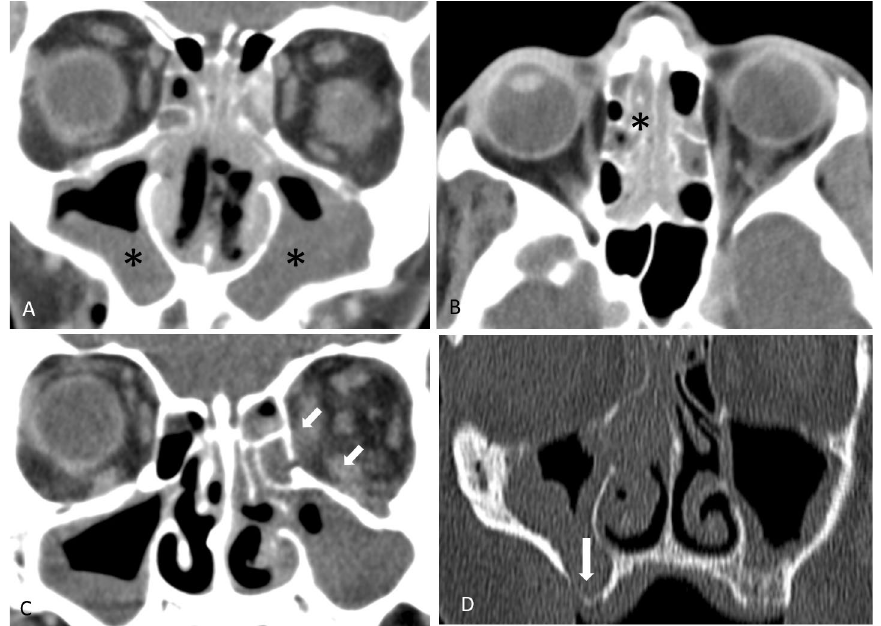
Figure 1. Examples of findings in patients with Mucor AIFR. ( A ) Coronal CT image shows bilateral mucosal thickening involving the maxillary sinuses (asterisks) and the nasal cavity. ( B ) Axial image in the same patient demonstrates bilateral mucosal thickening of ethmoid air cells (asterisk). ( C ) Coronal image in a different patient shows bilateral maxillary sinuses involvement and left orbital involvement with fatty infiltration of the left medial and inferior extraconal orbital fat (arrows). ( D ) Coronal CT of a different patient shows bilateral mucosal thickening of the maxillary sinuses with bony dehiscence along the inferior aspect of the right maxillary sinus.